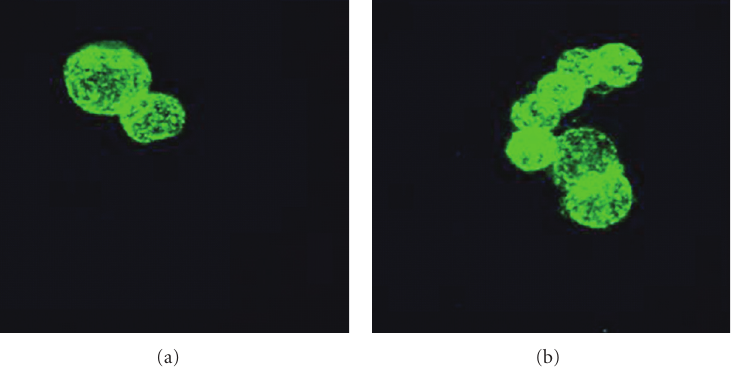
Figure 3: Confocal microscopy showing the interaction of (a) Bryothamnion seaforthii lectin, BSL, and (b) Bryothamnion triquetrum lectin, BTL PITC, labeled (at 37 ◦ C for 1 hour) with EB3 colon carcinoma cells variant. In this assay lectins were used at 10 μ g/mL. In each case the lectin uptake was strongly